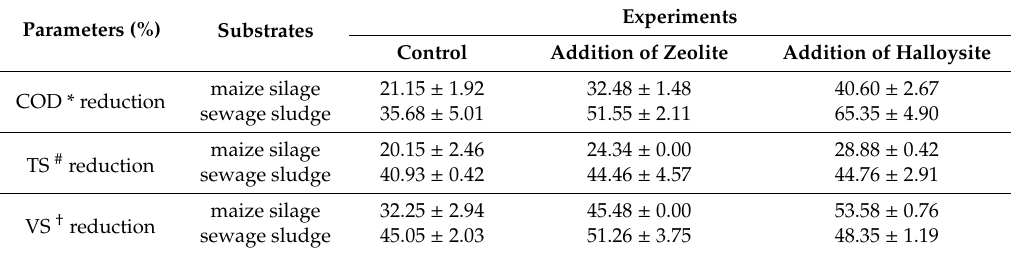
Table 3. Chemical oxygen demand, total solids, and volatile solids reduction percentage (%) achieved at the end of the batch anaerobic digestion process of maize silage and sludge sewage with or without minerals